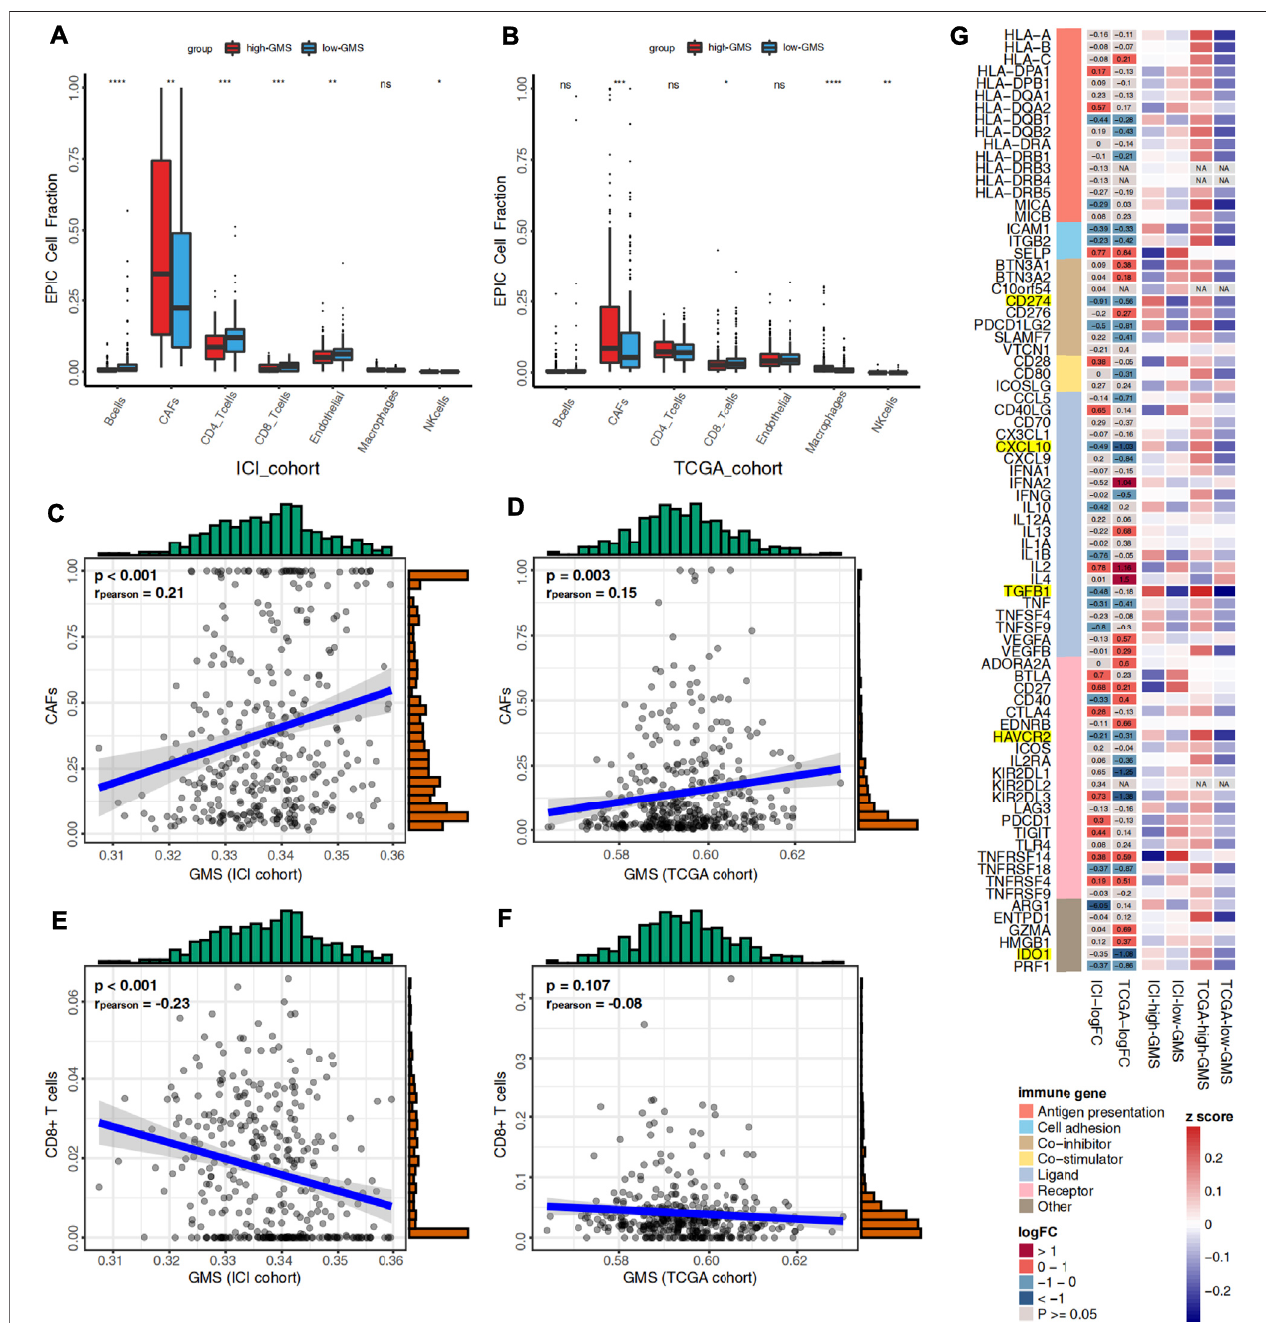
FIGURE4|(A) Boxplotvisualizestheproportionof7celltypesinthetumormicroenvironmentbetweenhigh-GMSandlow-GMSpatientsintheICIcohort. (B) Box plot visualizes the proportion of 7 cell types in the tumor microenvironment between high-GMS and low-GMS patients in the TCGA cohort. (C) The correlation between GMSandtheproportionofCAFsintheICIcohort. (D) ThecorrelationbetweenGMSandCAFsproportionintheTCGAcohort. (E) ThecorrelationbetweenGMSandthe proportion of CD8 + T cells in the ICI cohort. (F) The correlation between GMS and the proportion of CD8 + T cells in the TCGA cohort. (G) The Heatmap shows the expression levels of immune-related genes and immune exhaustion biomarkers between patients with high-GMS and low-GMS. The color in the fi rst column of the heatmap represents the classi fi cation of the molecules according to their immune functions, and the meaning of the colors is shown in the legend. The second and third columns exhibit the logFC and p -value of the analysis of the gene differential expression analysis. The color represents the size of logFC shown in the middle of the rectangles, while gray represents non-signi fi cant p -values. In the calculation of logFC, high-GMS patients were used as the control group. LogFC > 0 means that the geneswerehighlyexpressedinlow-GMSpatients,whilelogFC < 0istheopposite.Thelastfourcolumnsoftheheatmapshowtheaveragegeneexpressionlevels,which were standardized by z-score.